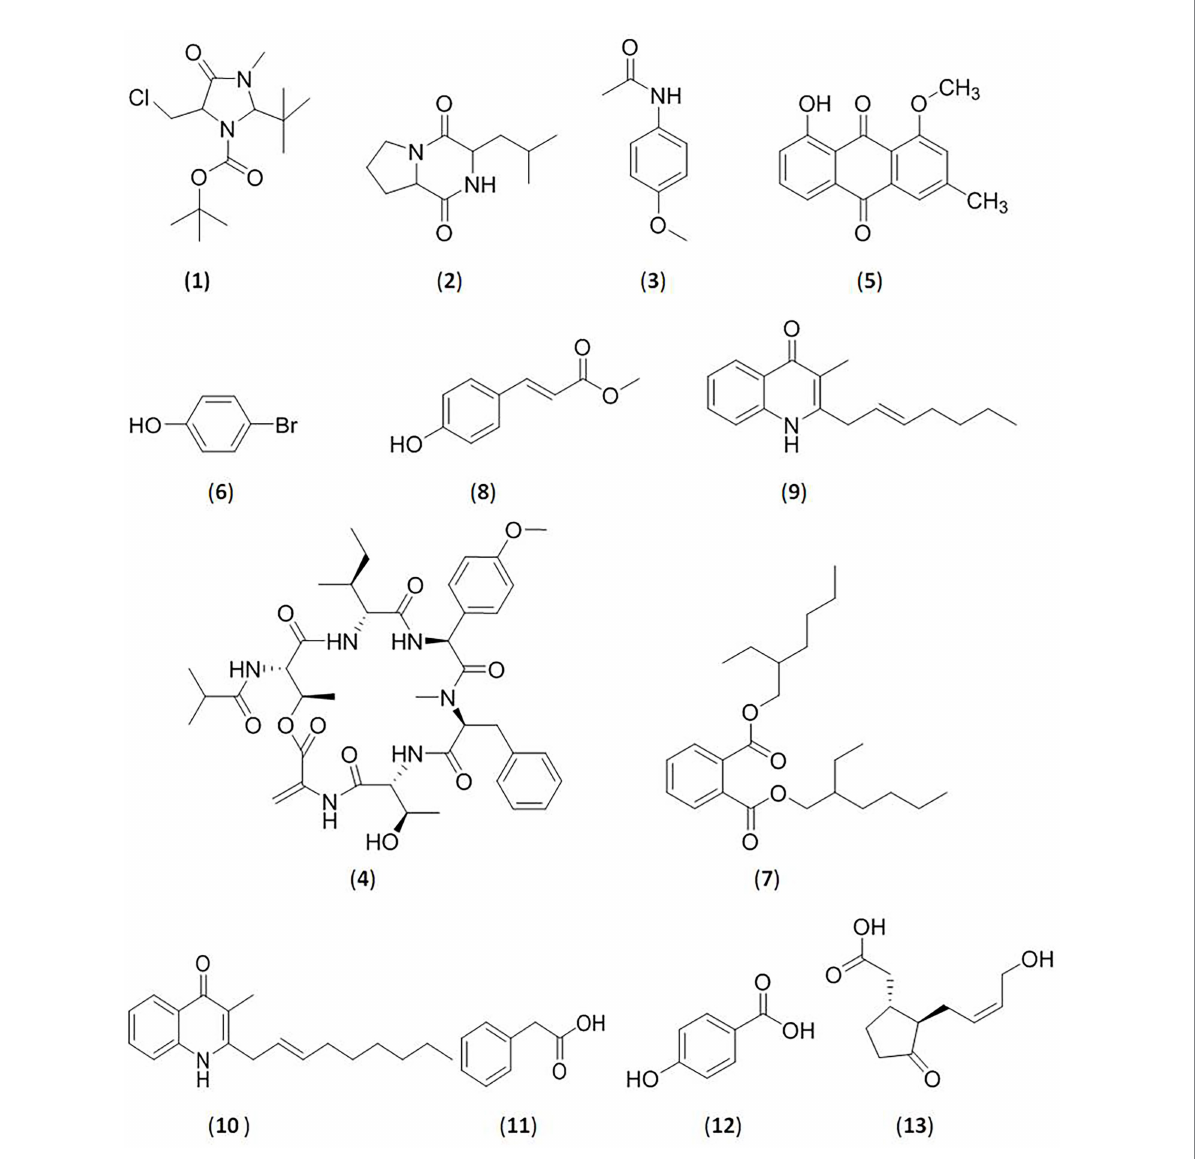
FIGURE 1 Glycosidase inhibitors compounds from bacteria. ( 1 ).2-t-butyl-5-chloromethyl-3-methyl-4-oxoimidazolidine-1-carboxylic acid, t-butyl ester; ( 2 ). pyrrolo[1–a]pyrazine-1,4-dione,hexahydro-3-(2-methylpropyl); ( 3 ).4-methoxyacetanilide; ( 4 ).isobutyryl hexapeptide TXS-2; ( 5 ).1-O-methyl chrysophanol (OMC); ( 6 ).bromophenol derivative; ( 7 ).bis (2-ethylhexyl) phthalate ; ( 8 ).methoxy ethyl cinnamate (ethyl